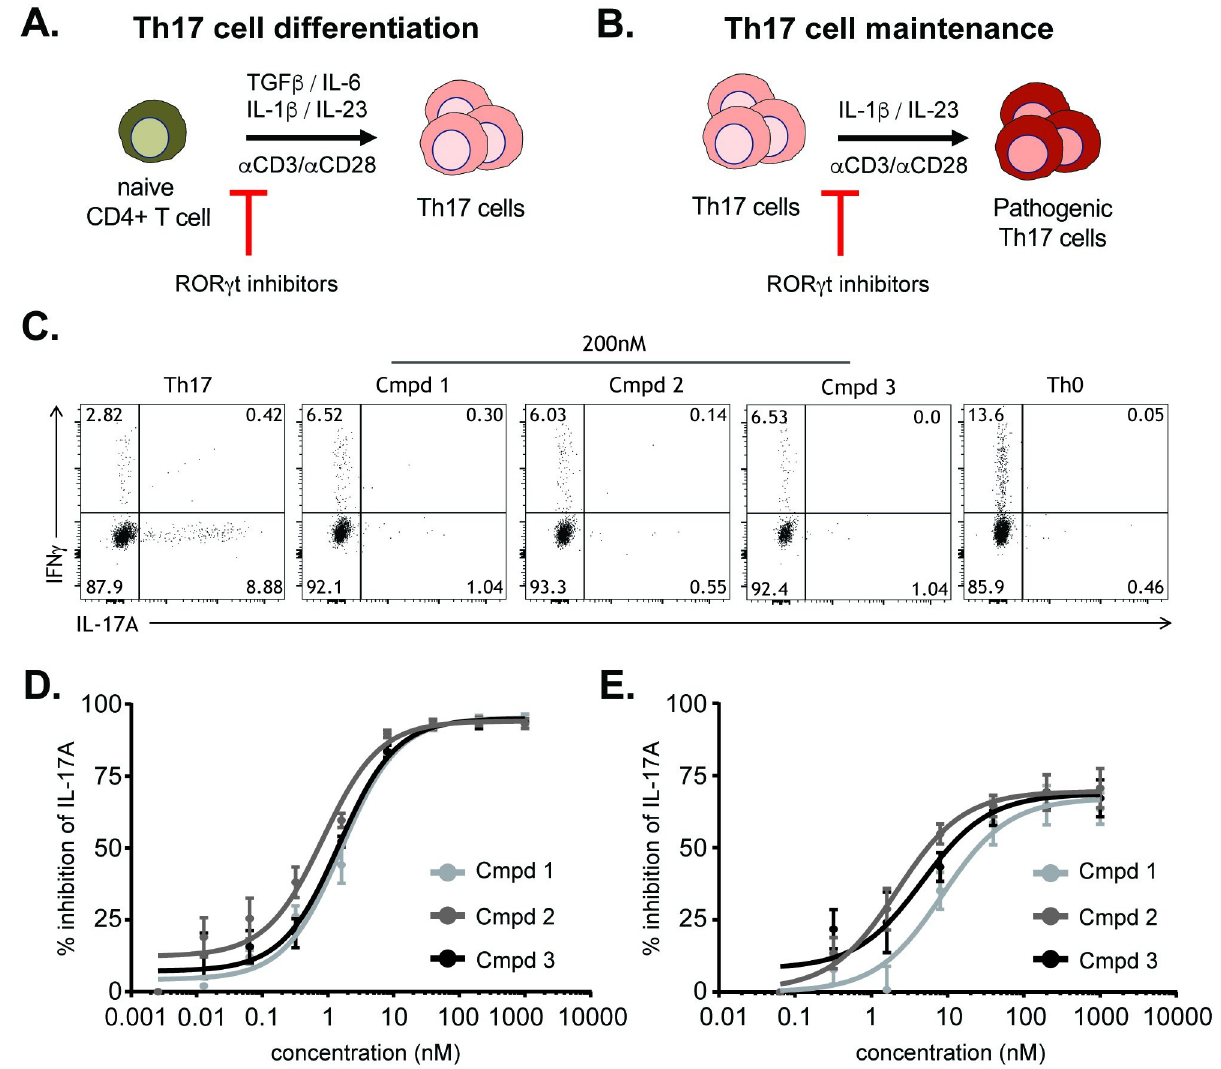
Fig 3. ROR γ t-mediated inhibition of IL-17A production in human Th17 cell cultures. Schematic of human Th17 differentiation (A) or Th17 maintenance (B) assays. Representative flow cytometry plots of intracellular cytokine staining from cultures from (A) including Th0 cell nonpolarizing condition (C) . IL-17A cytokine production from enriched na ï ve CD4 + T cells from healthy donor PBMC cultured under Th17 cell conditions for 6 days (D) or from enriched human Th17 cells from healthy donor PBMC cultured with IL-23 and IL-1 β , for 4 days (E) , in the presence of the indicated ROR γ t inhibitors Compounds 1–3 . Data are normalized to and represented as percent inhibition compared to DMSO controls. Error bars are representative of 4 individual donors, from 2 independent experiments.